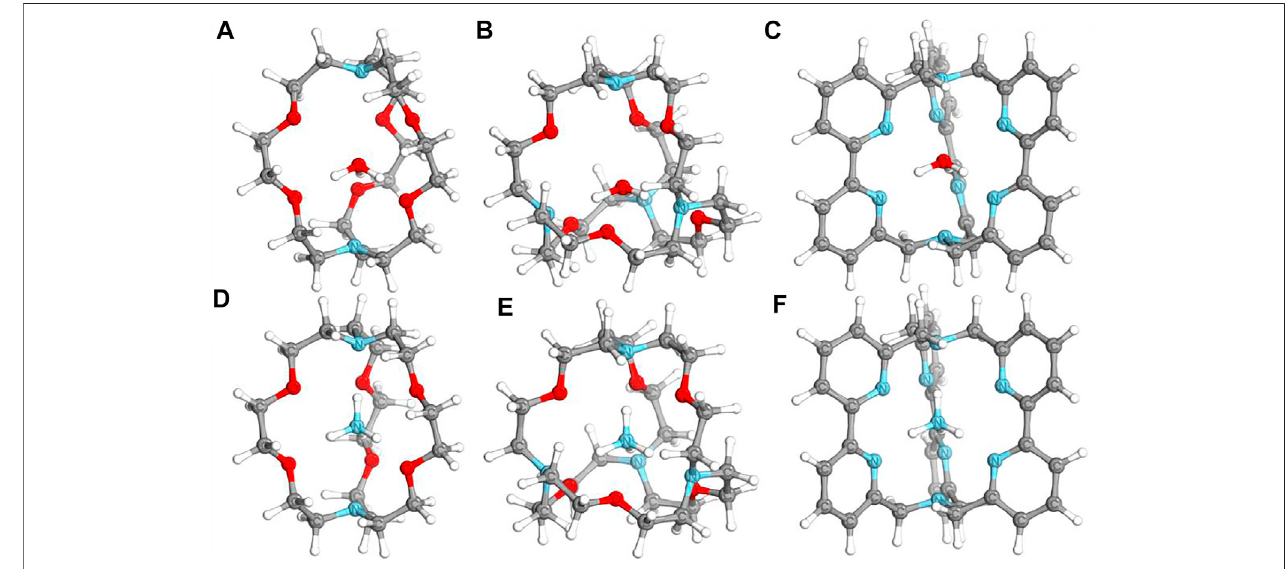
FIGURE 1 | Structures of optimized neutral complexes of NH 4 and H 3 O. (A) [H 3 O ⊂ [2.2.2]cryptand]; (B) [H 3 O ⊂ spherical cryptand]; (C) [H 3 O ⊂ [bpy.bpy.bpy] cryptand]; (D) [NH